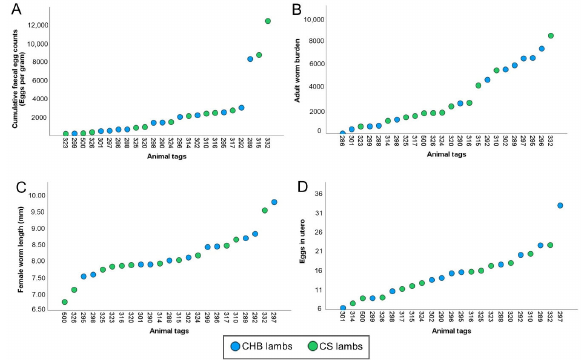
Figure 1. Parasitological variables in three ‐ month ‐ old sheep after trickle infection with Teladorsagia circumcincta infective larvae. Total cumulative faecal egg counts ( A ), worm burden at post ‐ mortem ( B ), length of female worms ( C ), and eggs in utero ( D ) are shown as individual means. Animal tags in the X ‐ axis are arranged from left to right according to ascending mean value ( n = 24).